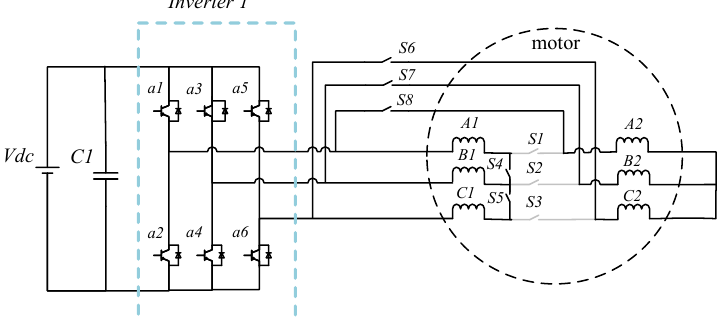
Figure 4. High-speed operation of RW.